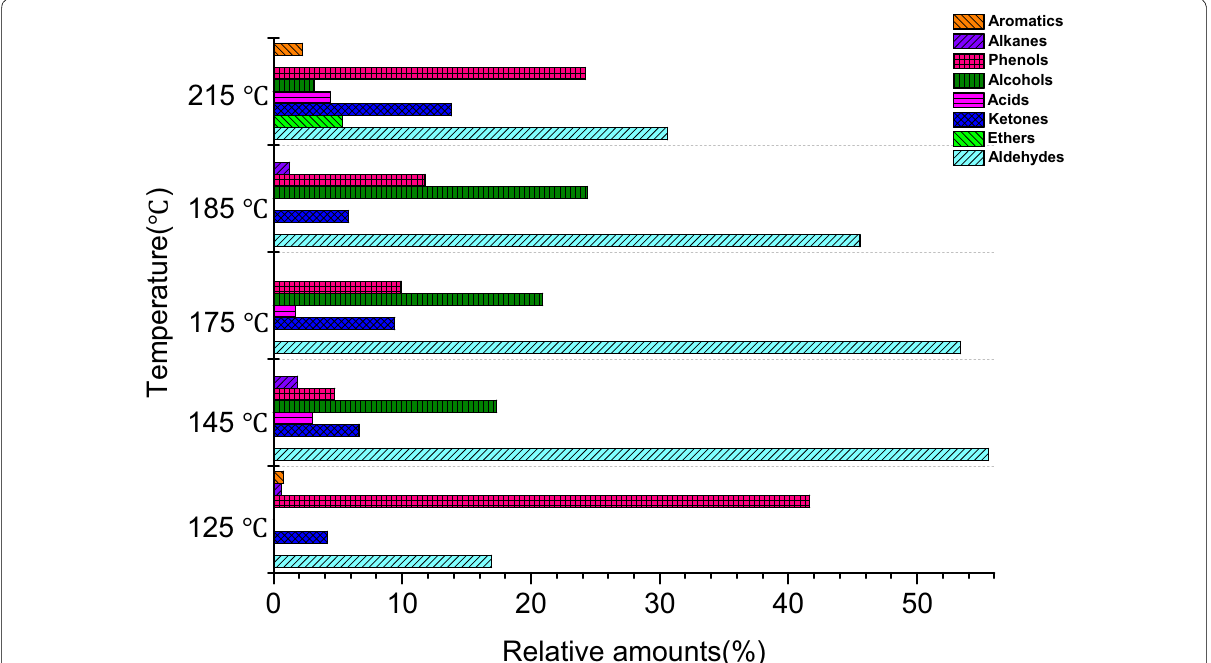
Fig. 2 Relative amounts of the effluents condensated by VOCs of rubberwood from different heat-treatment